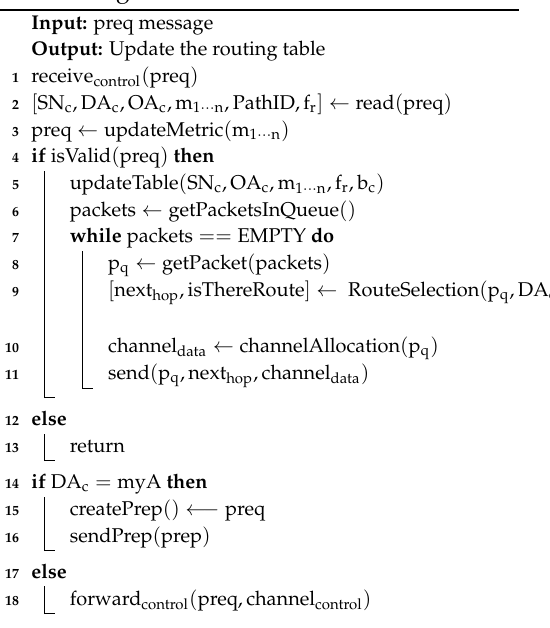
Algorithm 1: PREQ element process and